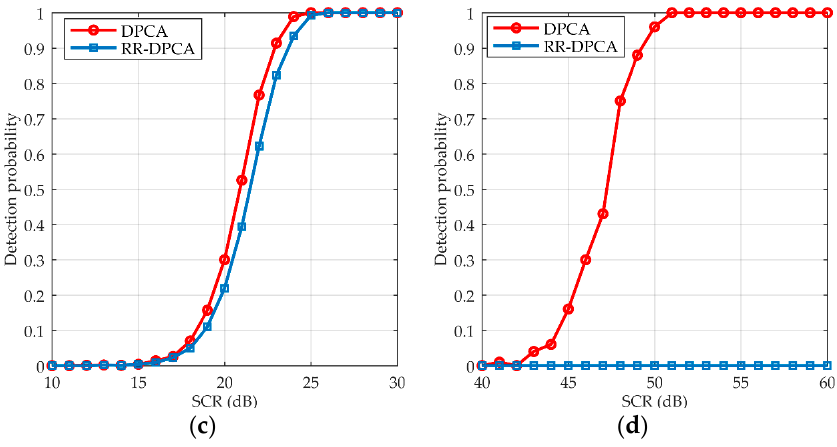
Figure 6. Point moving targets detection probability versus SCR with P fa = 10 − 6 . ( a ) v r =3.6 m/s; ( b ) v r = 0.3 m/s; ( c ) v r = 0.1 m/s; ( d ) v r = 0.05 m/s.